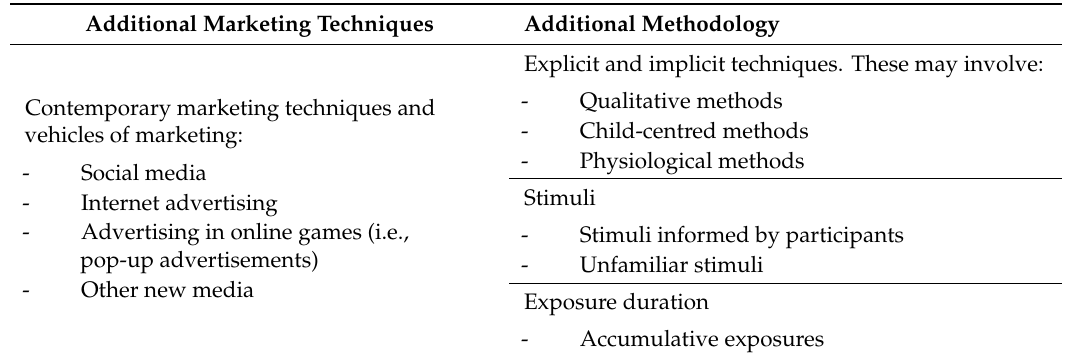
Table 2. Research gaps to be addressed in future